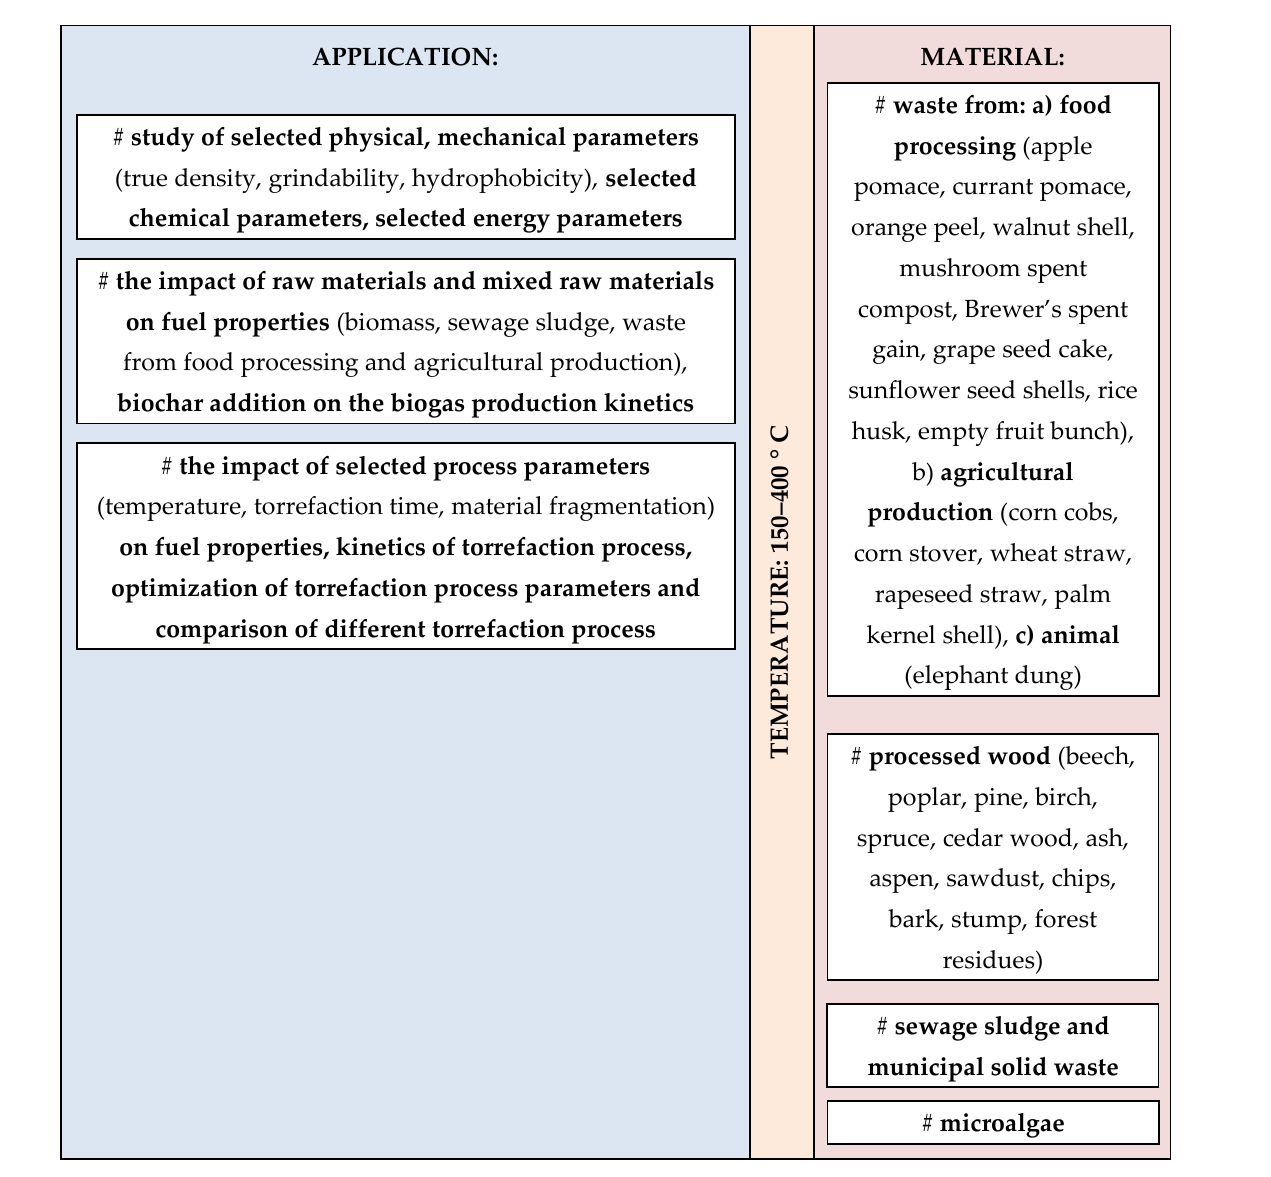
Figure 10. Main research topics and process parameters—torrefaction process. The second group concerned the hydrothermal carbonization (HTC) process and is presented in Figure 11 and Appendix A: Table A2. There are 10 publications in this group.